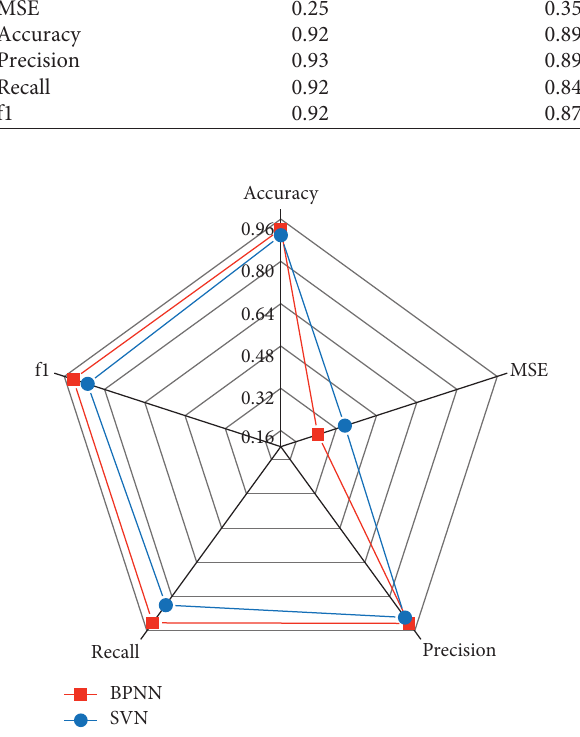
Figure 9: Comparison of evaluation results of BPANN and SVM models.